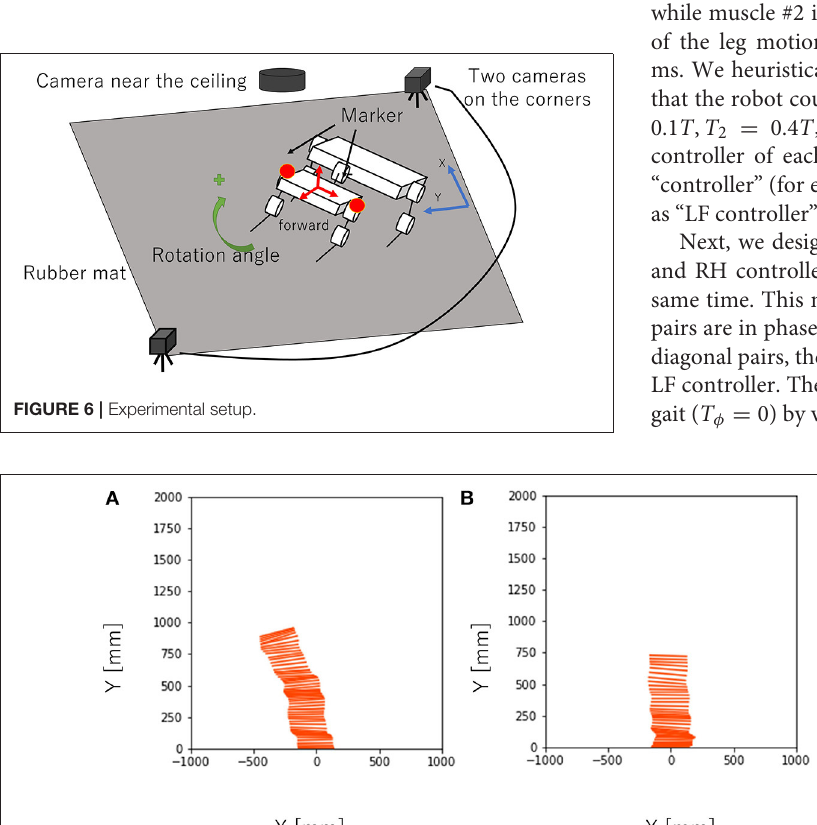
Frontiers in Robotics and AI |